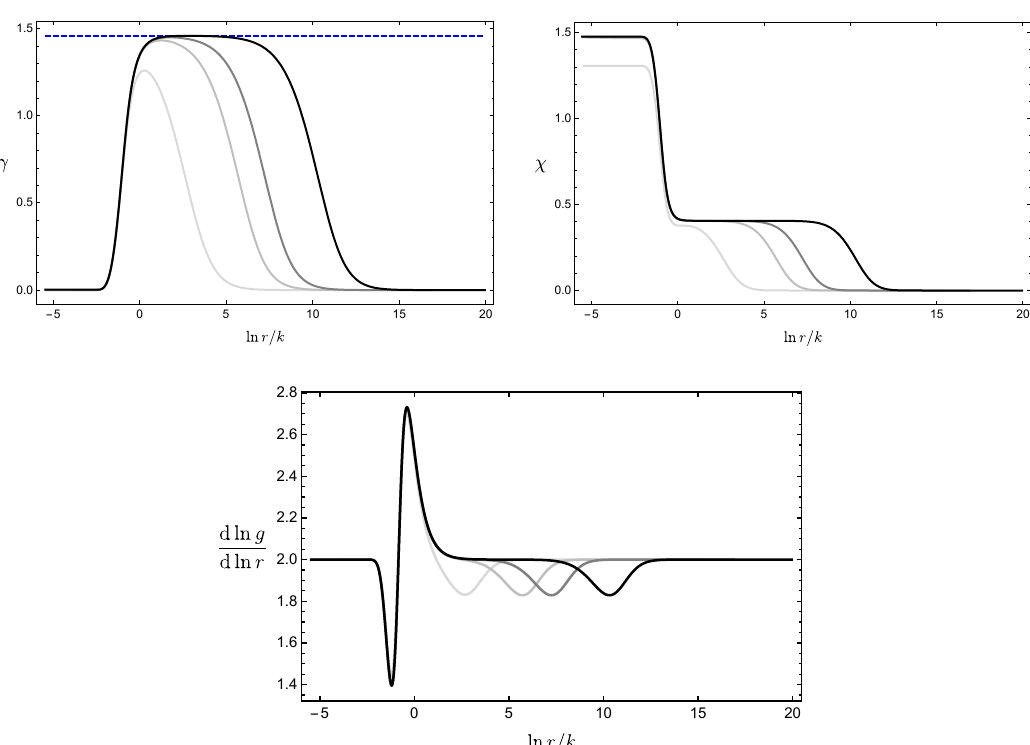
Figure 3 . Boomerang RG (cid:13)ows with (cid:0) =k 3 = 2 = 10 2 (lightest), 10 4 ; 10 5 and 10 7 (darkest) showing the build up of intermediate conformal invariance. The blue dashed line in the upper left plot shows the value of the scalar in the AdS c intermediate scaling region, dominated by the AdS c (cid:24) = 675 =